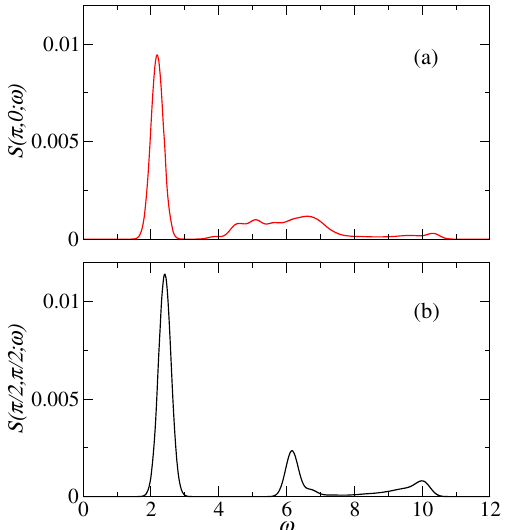
FIG. 20. Spectral functions of the effective model at (a) q ¼ ð π ; 0 Þ and (b) q ¼ ð π = 2 ; π = 2 Þ , using model parameters corresponding to the Heisenberg model: c m ¼ 3 . 1 , c s ¼ 3 . 1 , Δ ¼ 1 . 94 , g ¼ 1 . 86 , and the spinon-spinon potential V ð r Þ ¼ − 6 . 2 e − r= 2 (same as used in Figs. 18 and 19). The δ functions in the exact spectral function (computed here using an L ¼ 64 lattice) have been broadened for visualization.